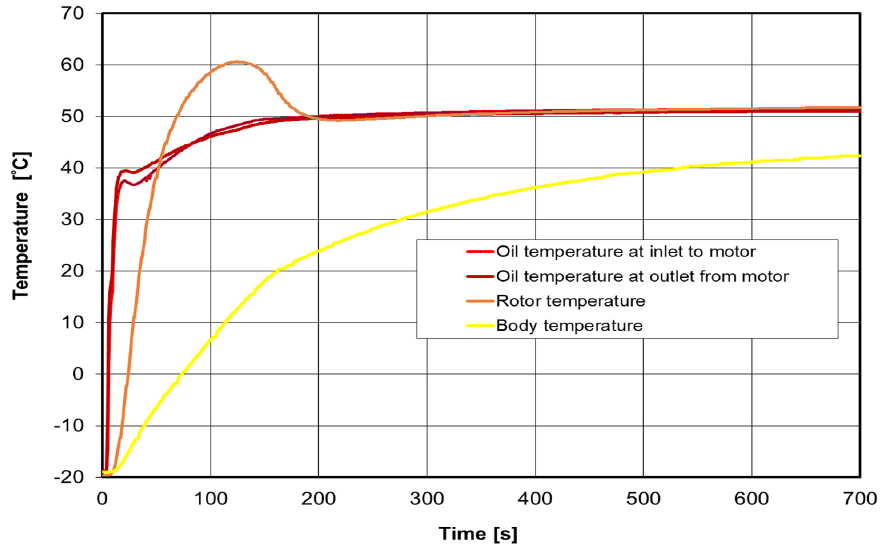
Figure 15. Characteristics of the temperature of rotor, body, and oil at the inlet and the outlet of the motor as a function of time (ambient temperature (motor) − 20 °C, obtained rotational speed approximately 255 rpm).